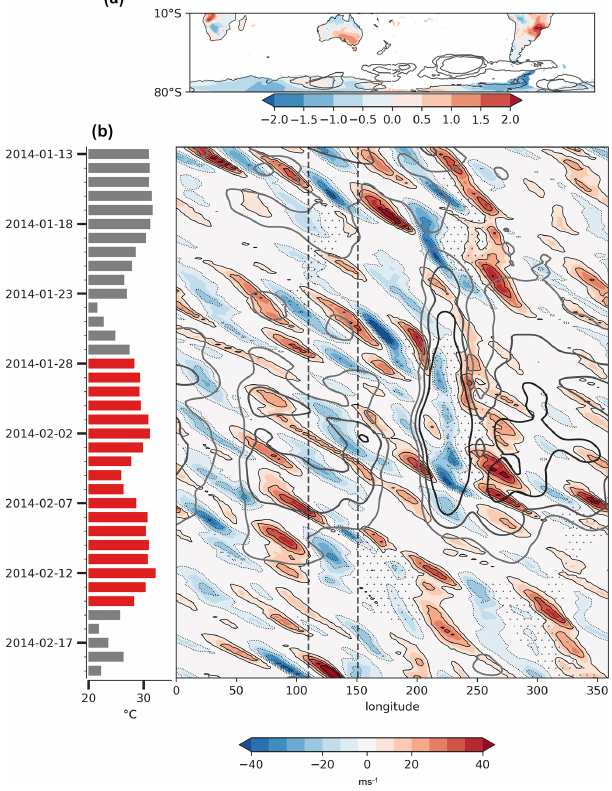
Figure B1. Same as in Fig. 4 but for January 2014 SEA